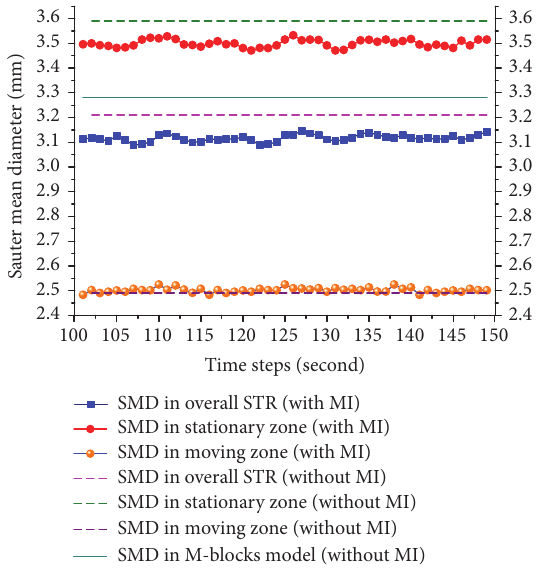
Figure10:SMDinstationary,moving,andoverallzoneinSTR. 𝑁 = = 0.12 vvm for the time 50 ∼ 150 250 rpm, 𝑄 𝑔